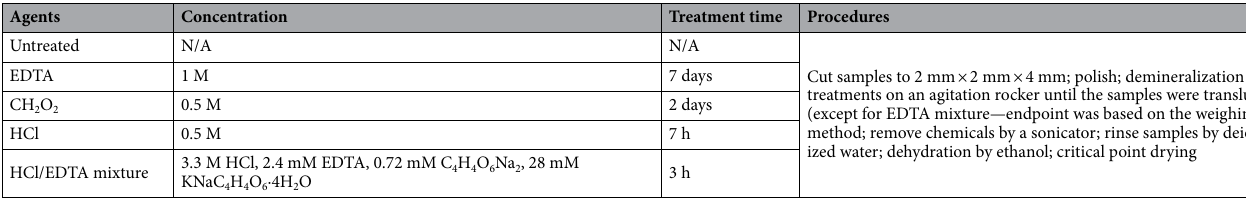
Table 1. Sample preparation by demineralization agents: EDTA (ethylene-diamine tetraacetic acid), formic acid (CH 2 O 2 ), hydrogen chloride (HCl), and HCl/EDTA